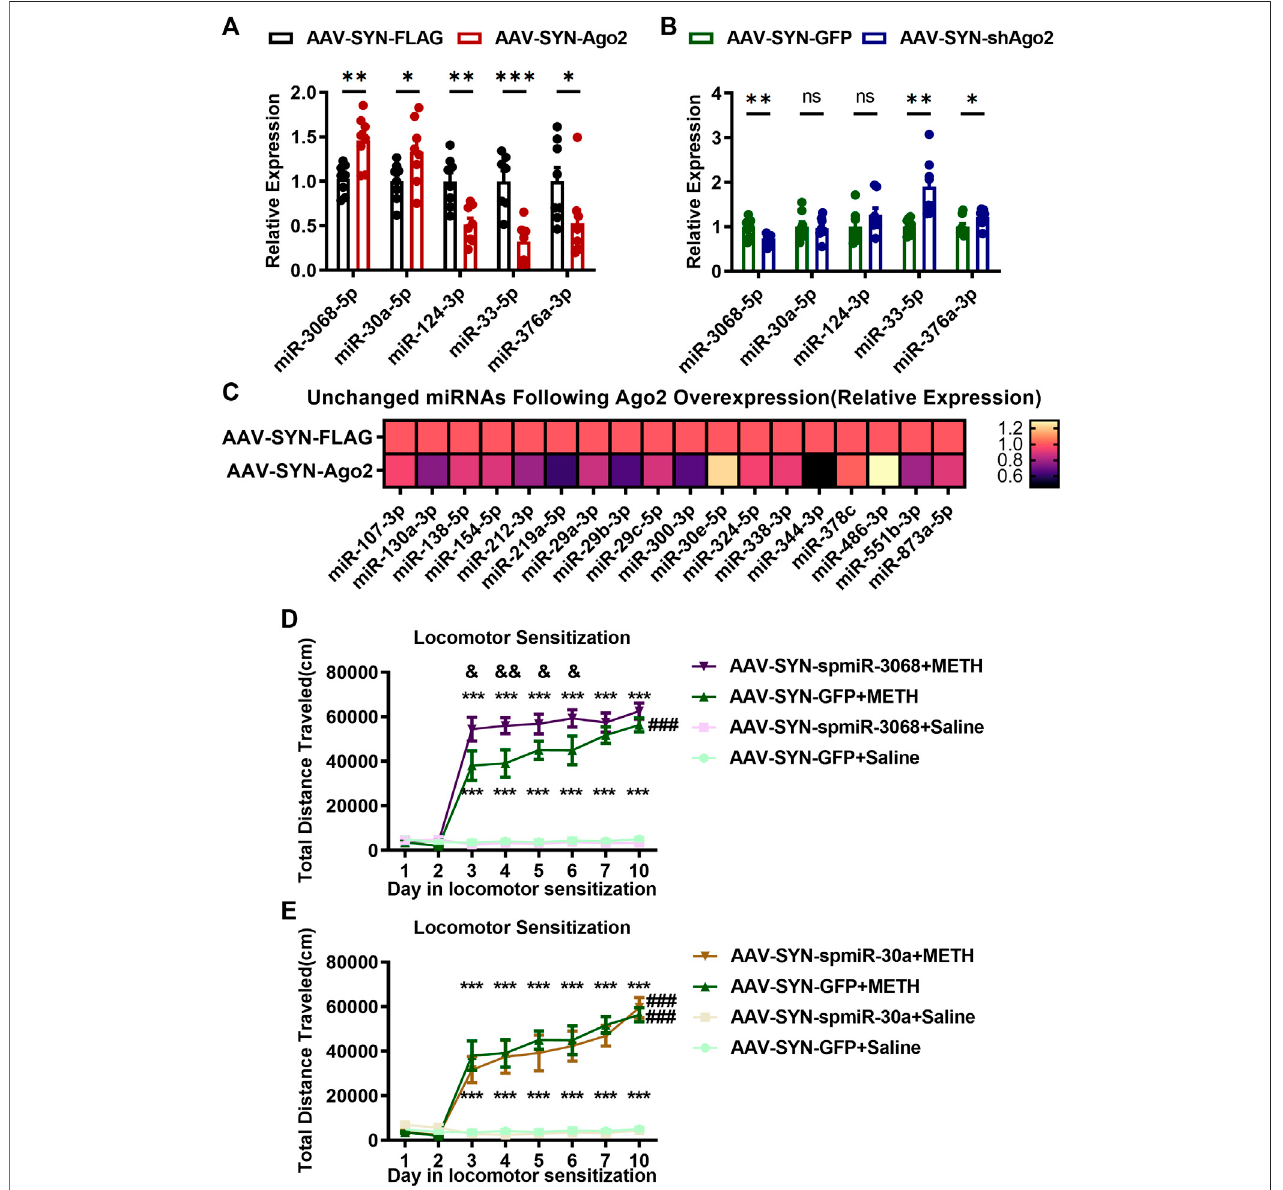
FIGURE3| miR-3068-5p wasfound tobean Ago2-dependentmiRNA in theNAc ofmice (A, C) .Changesin miRNA expression followingAgo2 overexpression in the NAc ofmice. Student ’ s t -test: * p < 0.05, ** p < 0.01, and *** p < 0.001 compared with the AAV-SYN-FLAG group. The data are presented as the mean ± SEM, n (cid:2) 8. (B) Changes in miRNA expression in the NAc of mice in the AAV-SYN-shAgo2 group. Student ’ s t -test: * p < 0.05 and ** p < 0.01 compared with the AAV-SYN-GFP group. Data are presented as the mean ± SEM, n (cid:2) 8. (D) miR-3068-5p interference in NAc neurons strengthens METH sensitization. (E) No change in METH sensitization after miR-30a-5p interference in NAc neurons. Mixed-measures ANOVA: *** p < 0.001, vs. the corresponding saline groups; & p < 0.05, && p < 0.01, AAV- SYN-spmiR-3068-5p+METH vs. AAV-SYN-GFP+METH; ### p < 0.001, compared to the locomotor activities recorded on day 3 within the same group. The data are presented as the mean ± SEM, n (cid:2) 8. NAc, nucleus accumbens; METH sensitization, METH-induced locomotor sensitization.